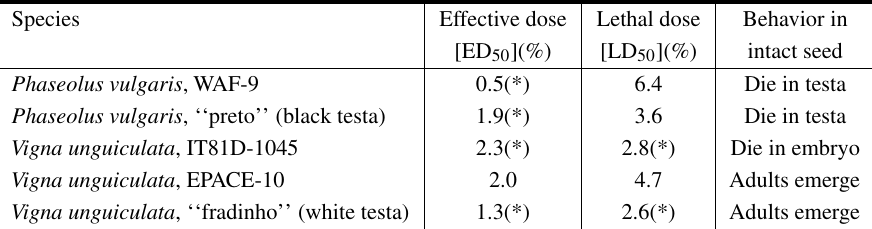
Effect of the addition of testa flours of Phaseolus vulgaris and Vigna unguiculata seeds on the development of Callosobruchus maculatus .